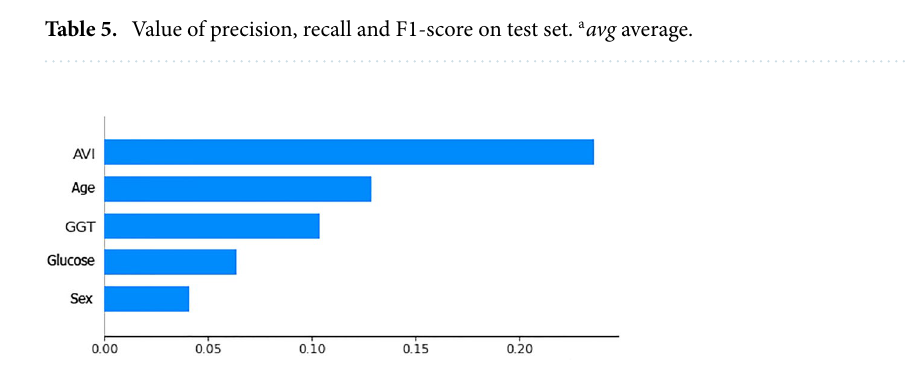
Figure 5. Histogram of feature relevance of anthropometric and biochemical parameters considered during